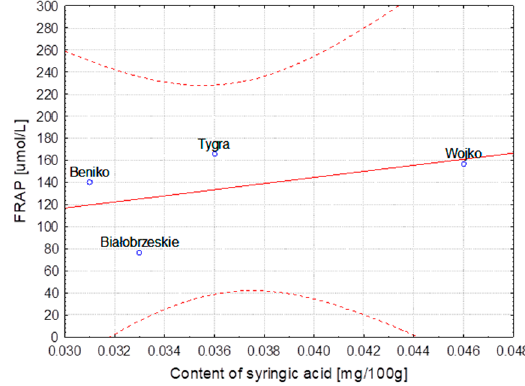
Figure 2. Method extraction of hemp—Dependence of FRAP [ μ mol/L] vs. content of syringic acid [mg/100 g] (y = 43.999 + 810.796x; C = 95%).